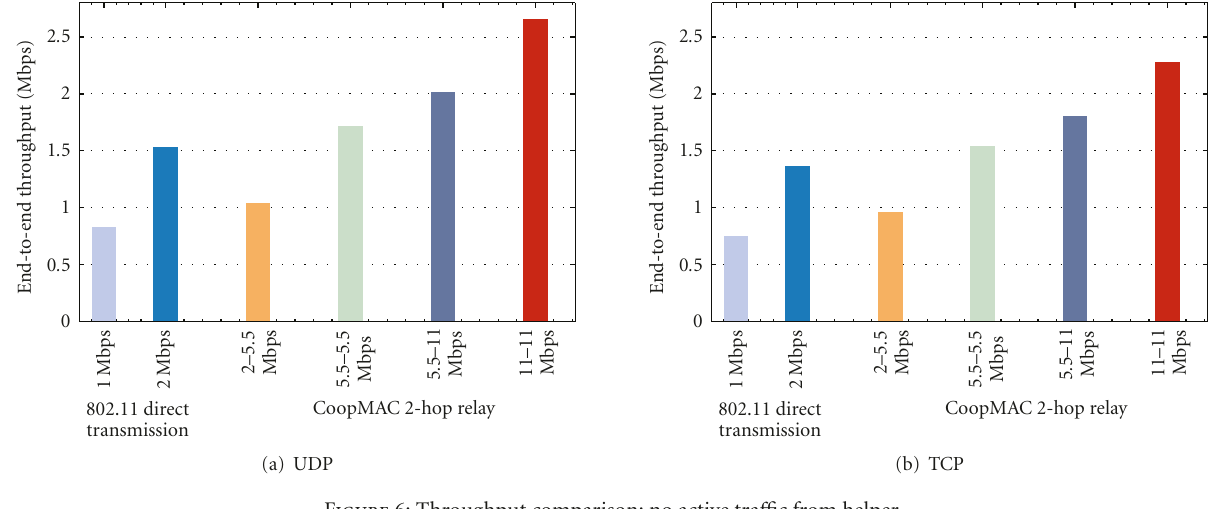
Figure 6: Throughput comparison: no active tra ffi c from helper.